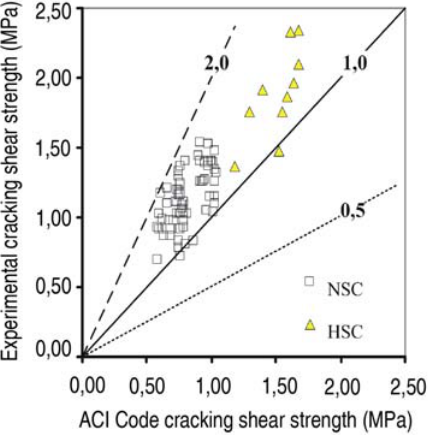
Fig. 2. Cracking shear strength values using ACI Code versus experimental cracking shear strength values